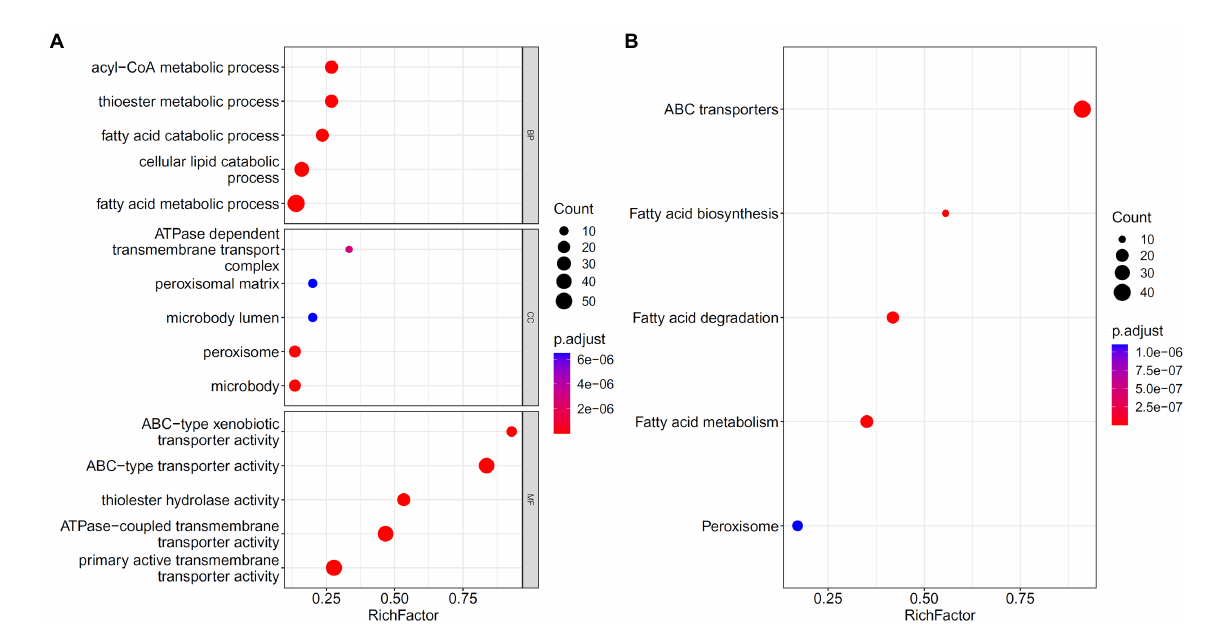
FIGURE 8 Gene ontology (GO) and KEGG pathway enrichment analysis on the union of five feature sets used to construct feasible random forest classifiers. The FDR < 0.05 criterion was used to filter GO terms and KEGG pathways. The top five significant GO terms in three GO clusters (A) and top five KEGG pathways (B) were shown.